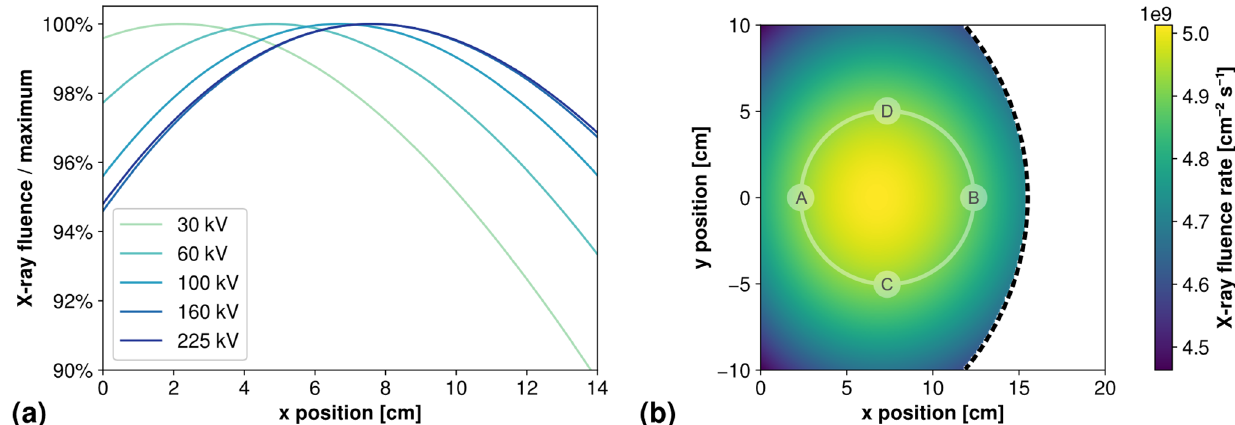
Figure 4. ( a ) Simulated fluence (normalized by maximum) of the X-ray beam according to position on the x-axis and X-ray tube voltage, at vertical position z = 42.5 cm. ( b ) Simulated fluence rate map of the X-ray beam at a position of z = 42.5 cm, tube voltage of 100 kV and current of 20 mA. Dashed contour shows the limits of the X-ray beam 40° cone, and solid contour shows the outline of an OF sample, with the location of the four dosimetry points A, B, C and D, each drawn inside a circle indicating the size of the ionization chamber sensitive surface.